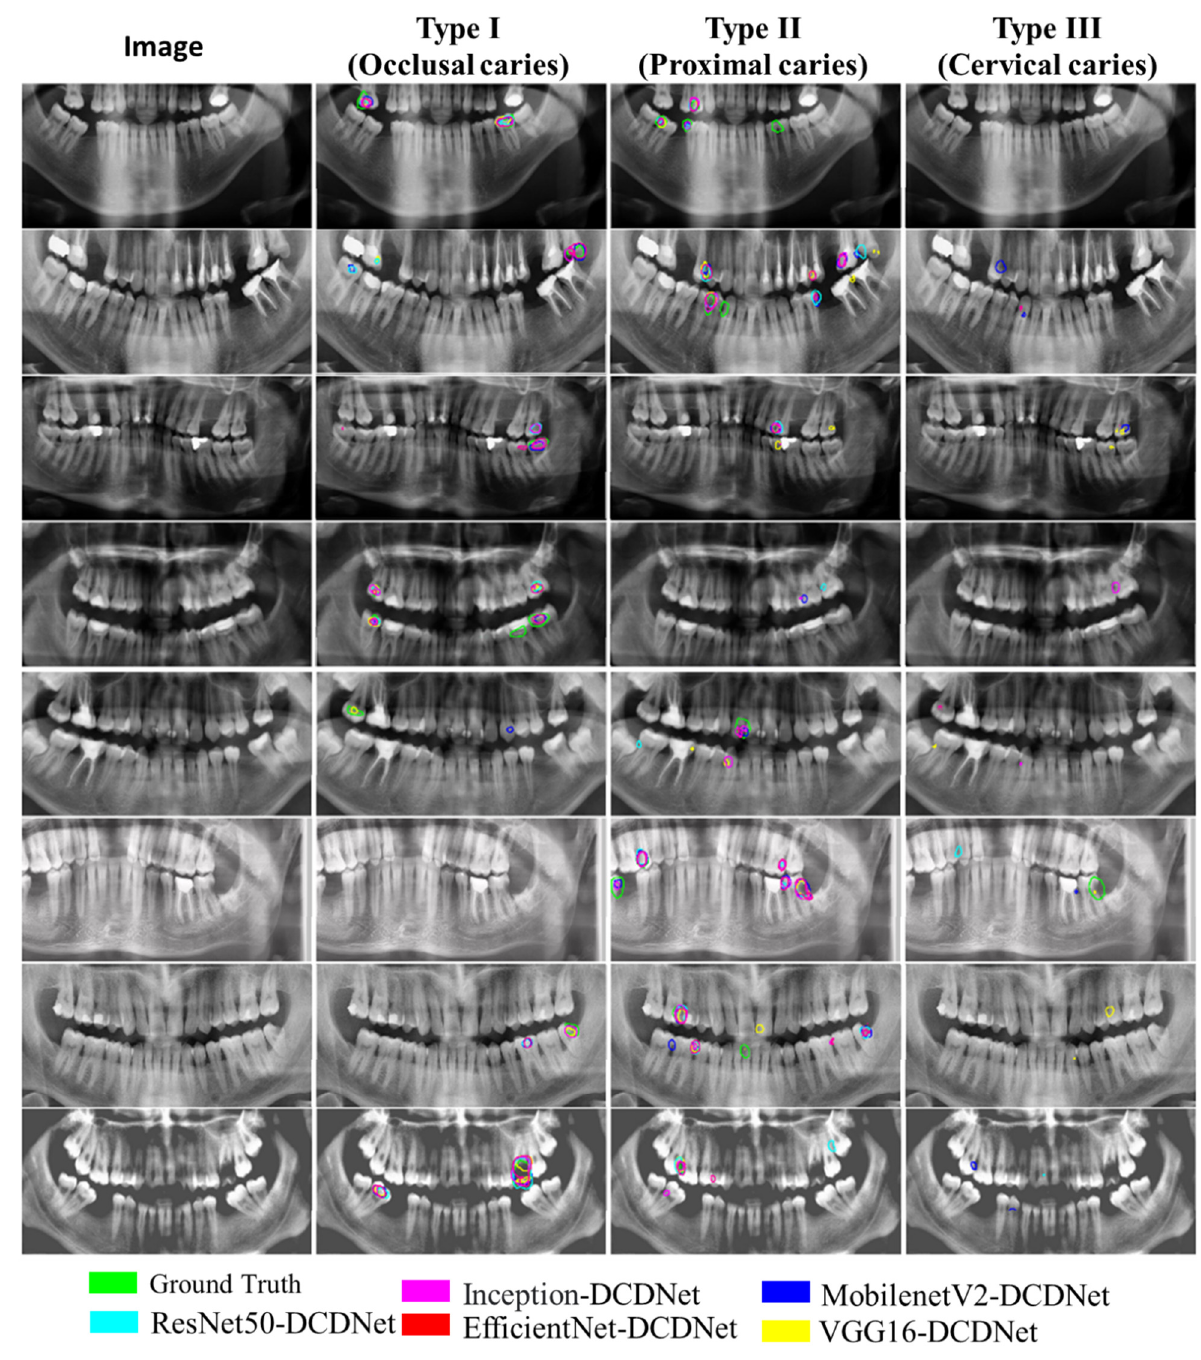
Figure 3. Sample images from the dataset and the prediction outputs of the models.